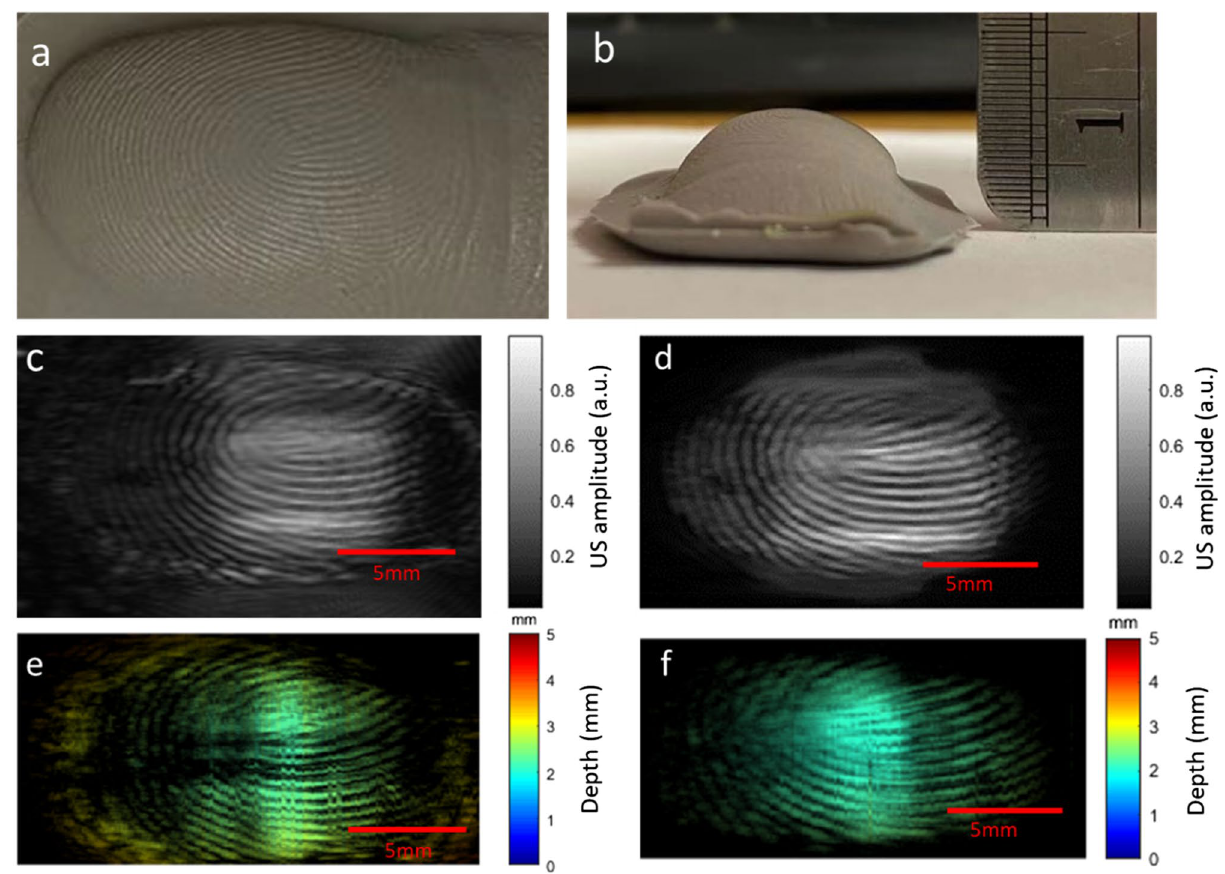
Figure 3. Imaging results for leaf phantom and artificial fingerprint spoof. ( a ) Photography of the top view of finger spoof. ( b ) Photography of the front view of finger spoof. ( c ) Ultrasound image of the spoof with coupling. ( d ) Ultrasound image of the spoof without coupling. ( e ) Depth-encoded photoacoustic image of the spoof with coupling. ( f ) Depth-encoded photoacoustic image of the spoof without